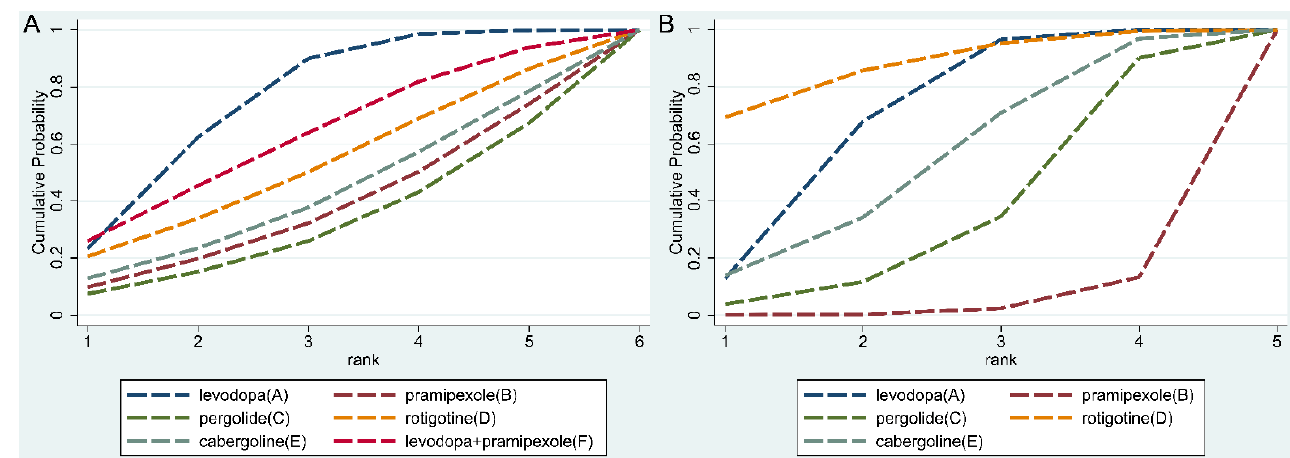
Figure 4. Surface under the cumulative ranking curve (SUCRA). ( A ) SUCRA of all included drugs on letter fluency; ( B ) SUCRA of all included drugs on semantic fluency. The funnel plot (Figure 5A) indicated that no publication bias